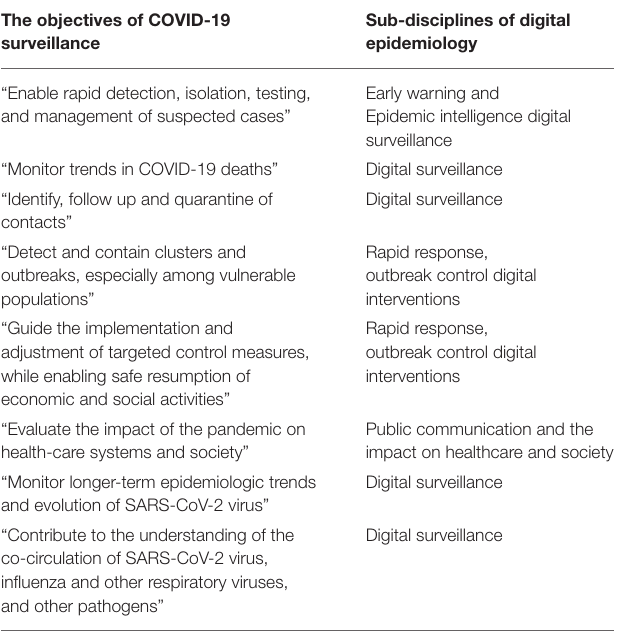
TABLE 1 | Mapping of four digital epidemiology disciplines to WHO objectives of COVID-19 surveillance. The objectives of COVID-19